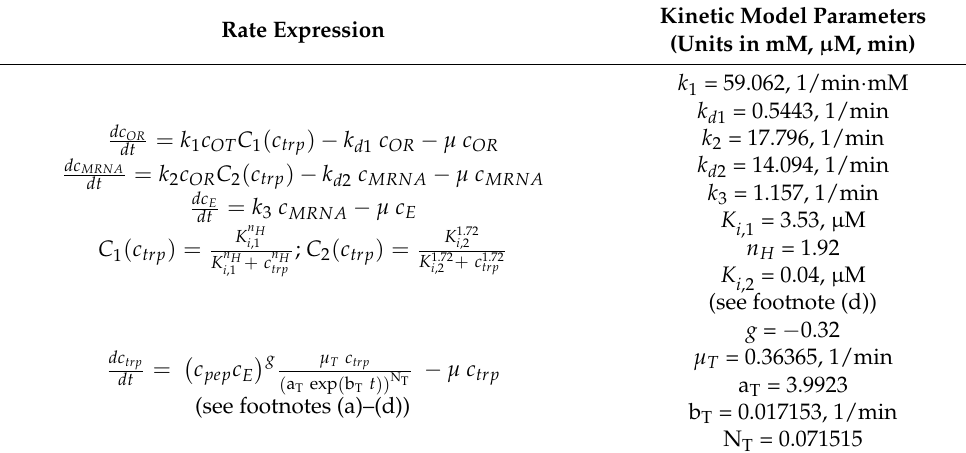
Table 4. The mass balances in the kinetic module [c]. Species mass balances in the TRP operon expression kinetic model of Bhartiya et al. [81] were modified by Maria et al. [37] to better fit the experimental data, as follows: (i) PEP (from glycolysis) is the substrate of TRP synthesis and the node coupling this synthesis with the glycolysis [a] module; (ii) a novel model for the TRP synthesis inhibition was proposed and identified from experiments. The model rate constants were estimated by Maria [35] to fit the experimental data of Chen [74] (Figures 4–8) collected in the FBR using the modified E. coli T5 strain, under “nominal” operating conditions (Table 1). Species notations (TRP, OR, OT, mRNA, and E) are given in the abbreviation list. QSS = quasi-steady state. Kinetic Model Parameters Rate Expression (Units in mM, µ M,